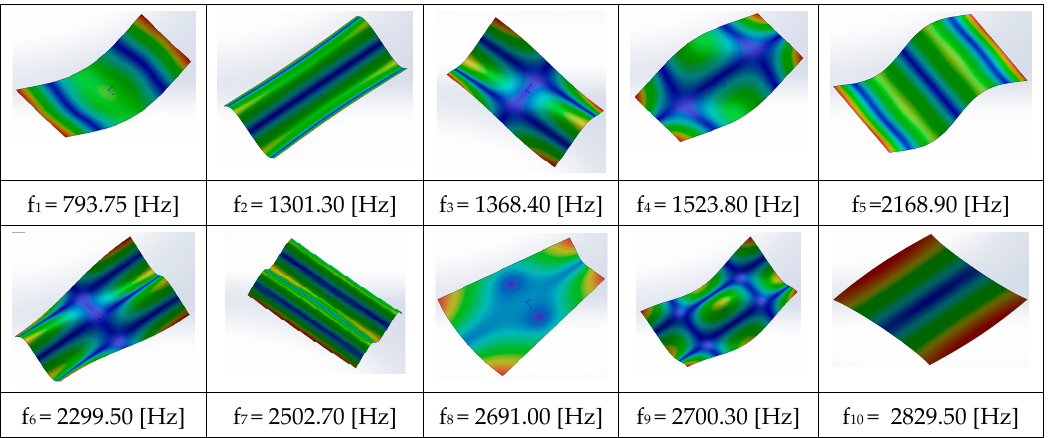
Figure 3. Mode shapes and the associated modal frequencies.